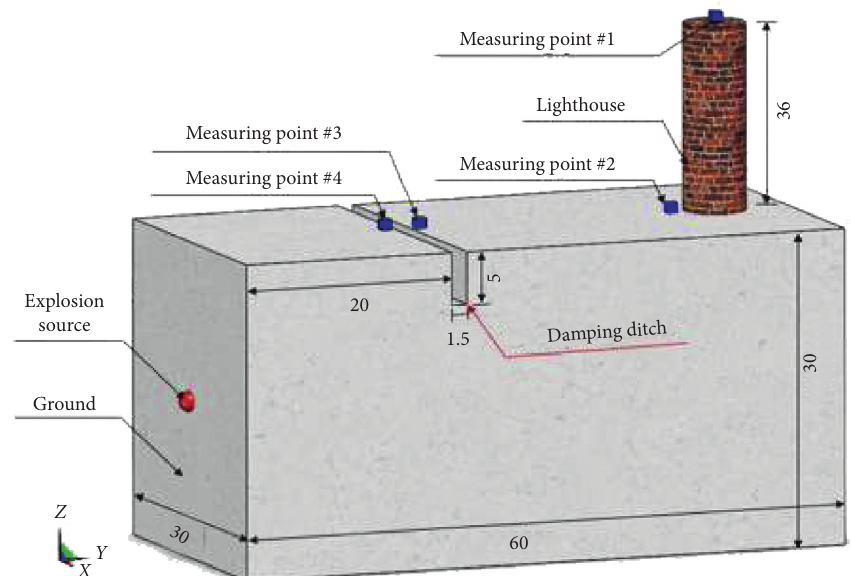
Figure 1: Schematic diagram of the vibration source, damping ditch, and lighthouse location (unit: